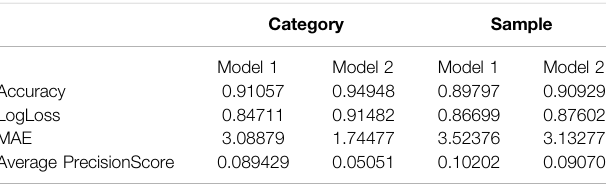
TABLE 1 | Performance metrics used for two different NN models on category- labeled and sample-labeled